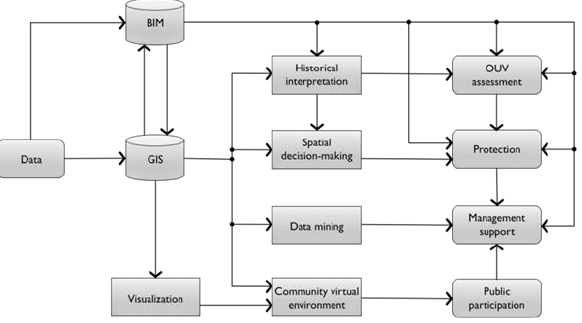
Figure 1. Structure of the proposed database (He,2012)